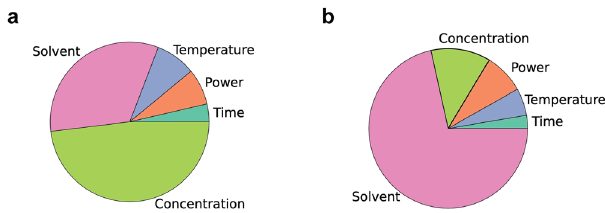
Fig. 5 Pie charts showing the relative importance of each synthesis variable. a On crystallinity. b Yield. We use SHAP (SHapley Additive explanations) values to quantify the importance of variables. SHAP values quantify how each variable in fl uences the outcome of the machine learning model using a game theoretic approach